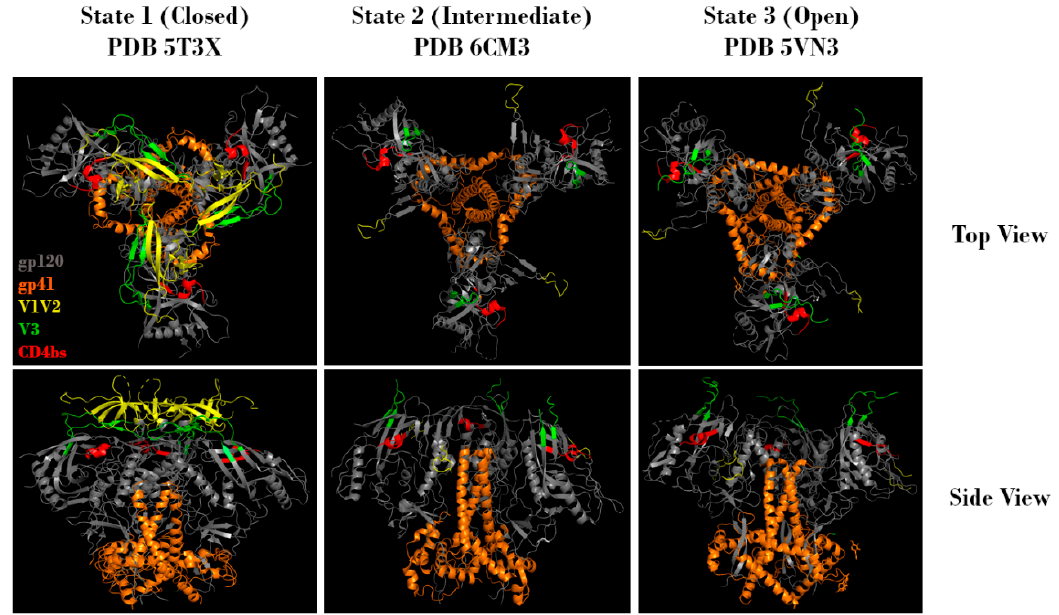
Figure 2. Representative top and side views of Env trimers in state 1 (closed), state 2 (intermediate), and state 3 (open) conformations. Regions corresponding to gp120 (grey), gp41 (orange), V1V2 (yellow), V3 (green), and the CD4 binding site (red) are indicated. Protein Data Bank identifier (PDB ID) numbers are also indicated. Structures adapted from Gristick et al., 2016 [26] , Bjorkman et al., 2018 [27] , and Ozorowski et al., 2017 [28] .